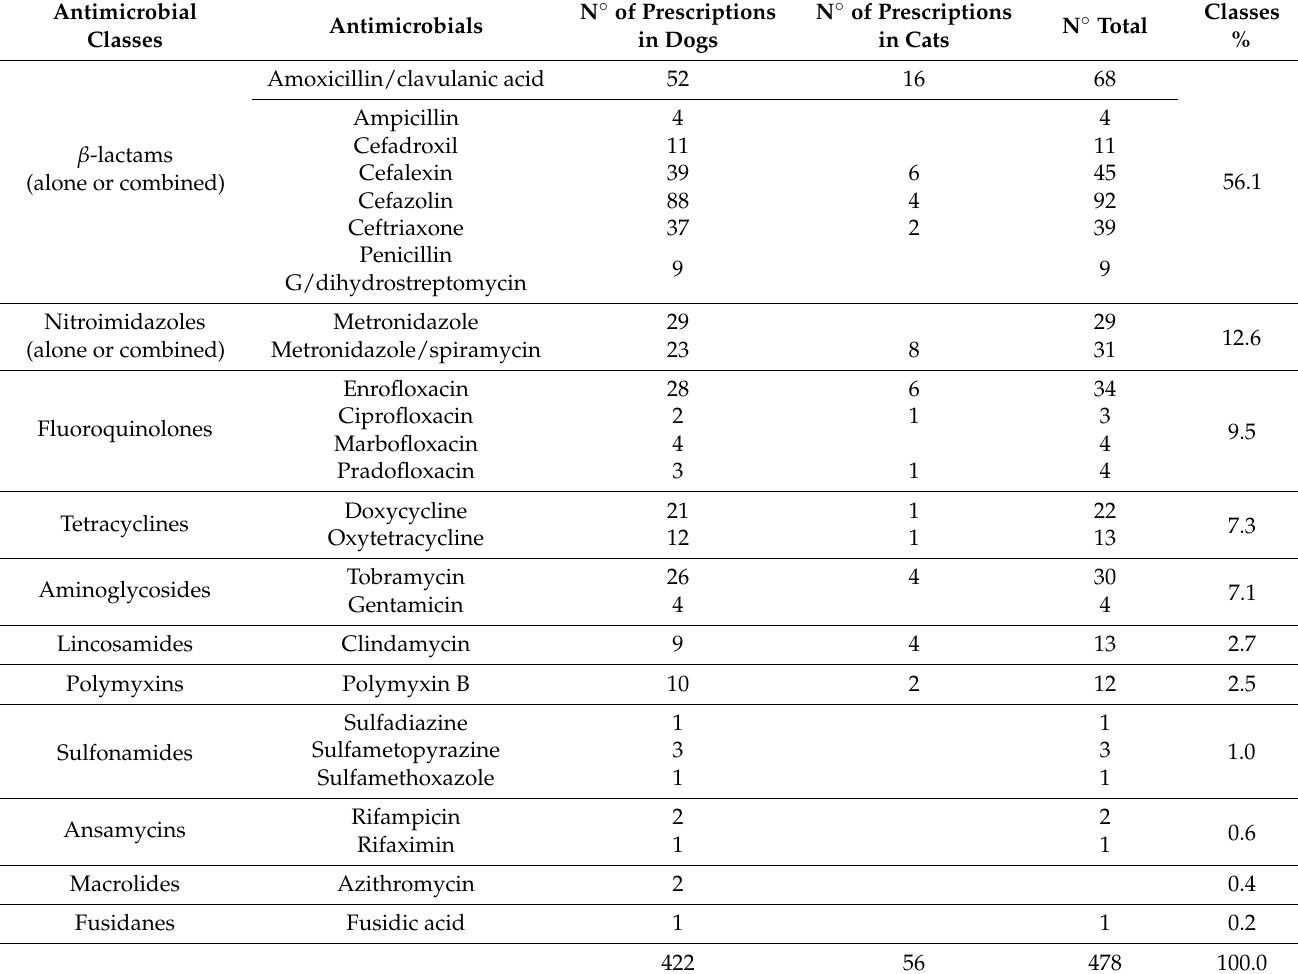
Table 1. Antimicrobials prescribed in dog and cat before the mandatory use of veterinary electronic prescription (VEP) (from April 2018 to March 2019).